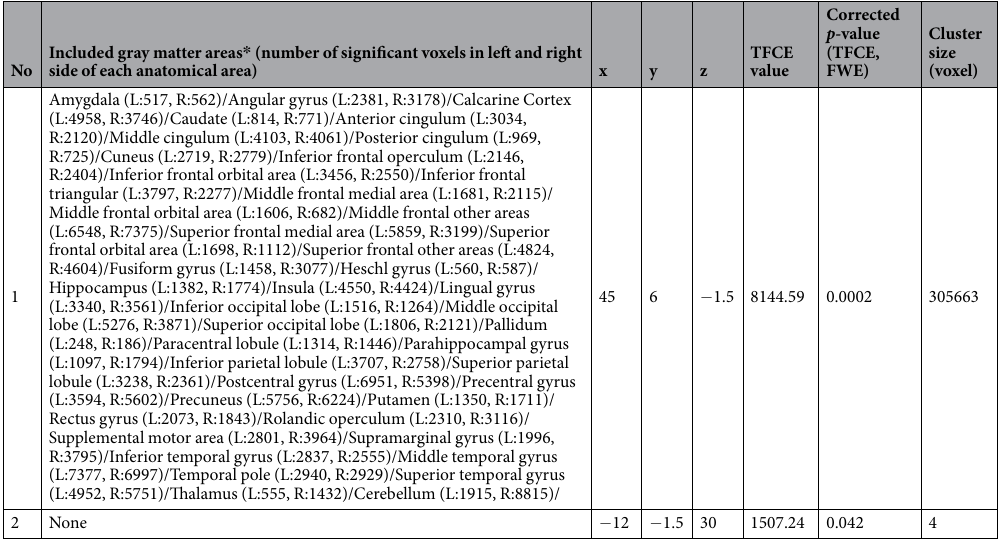
Included gray matter areas * (number of significant voxels in left and right No side of each anatomical area)